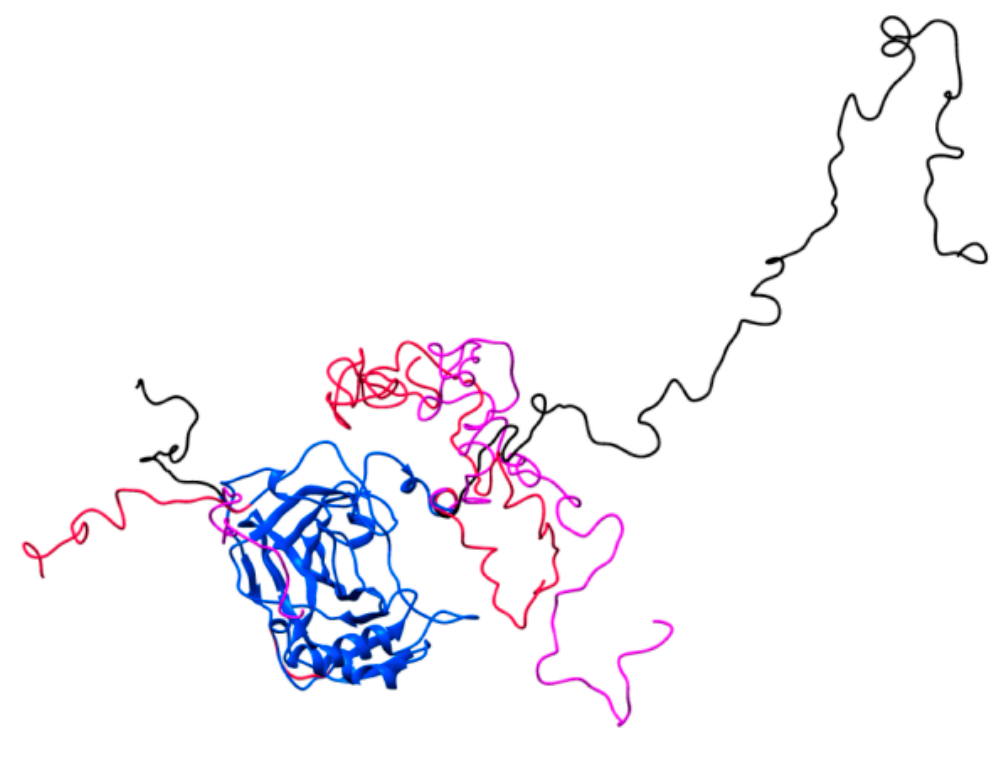
Figure 6. The best fit ensemble models of CA IX and PG domains from EOM analysis of SEC-SAXS data. Here, the core catalytic domain (shown in blue) CA IX from the crystal structure (PDB ID 3iai) was kept fixed, and EOM determined the possible conformations of the PG domain, which are highlighted in a range of colors and as random-loops. Compact structures representative of ~90% of the states in solution are shown in red and purple, while an extended structure, representative of the remaining minority conformations in solution, is shown in black. These models are representative of common structures in solution, but are meant only to aid in interpretation of what compact states are, and do not show the full range of possible solution structures.